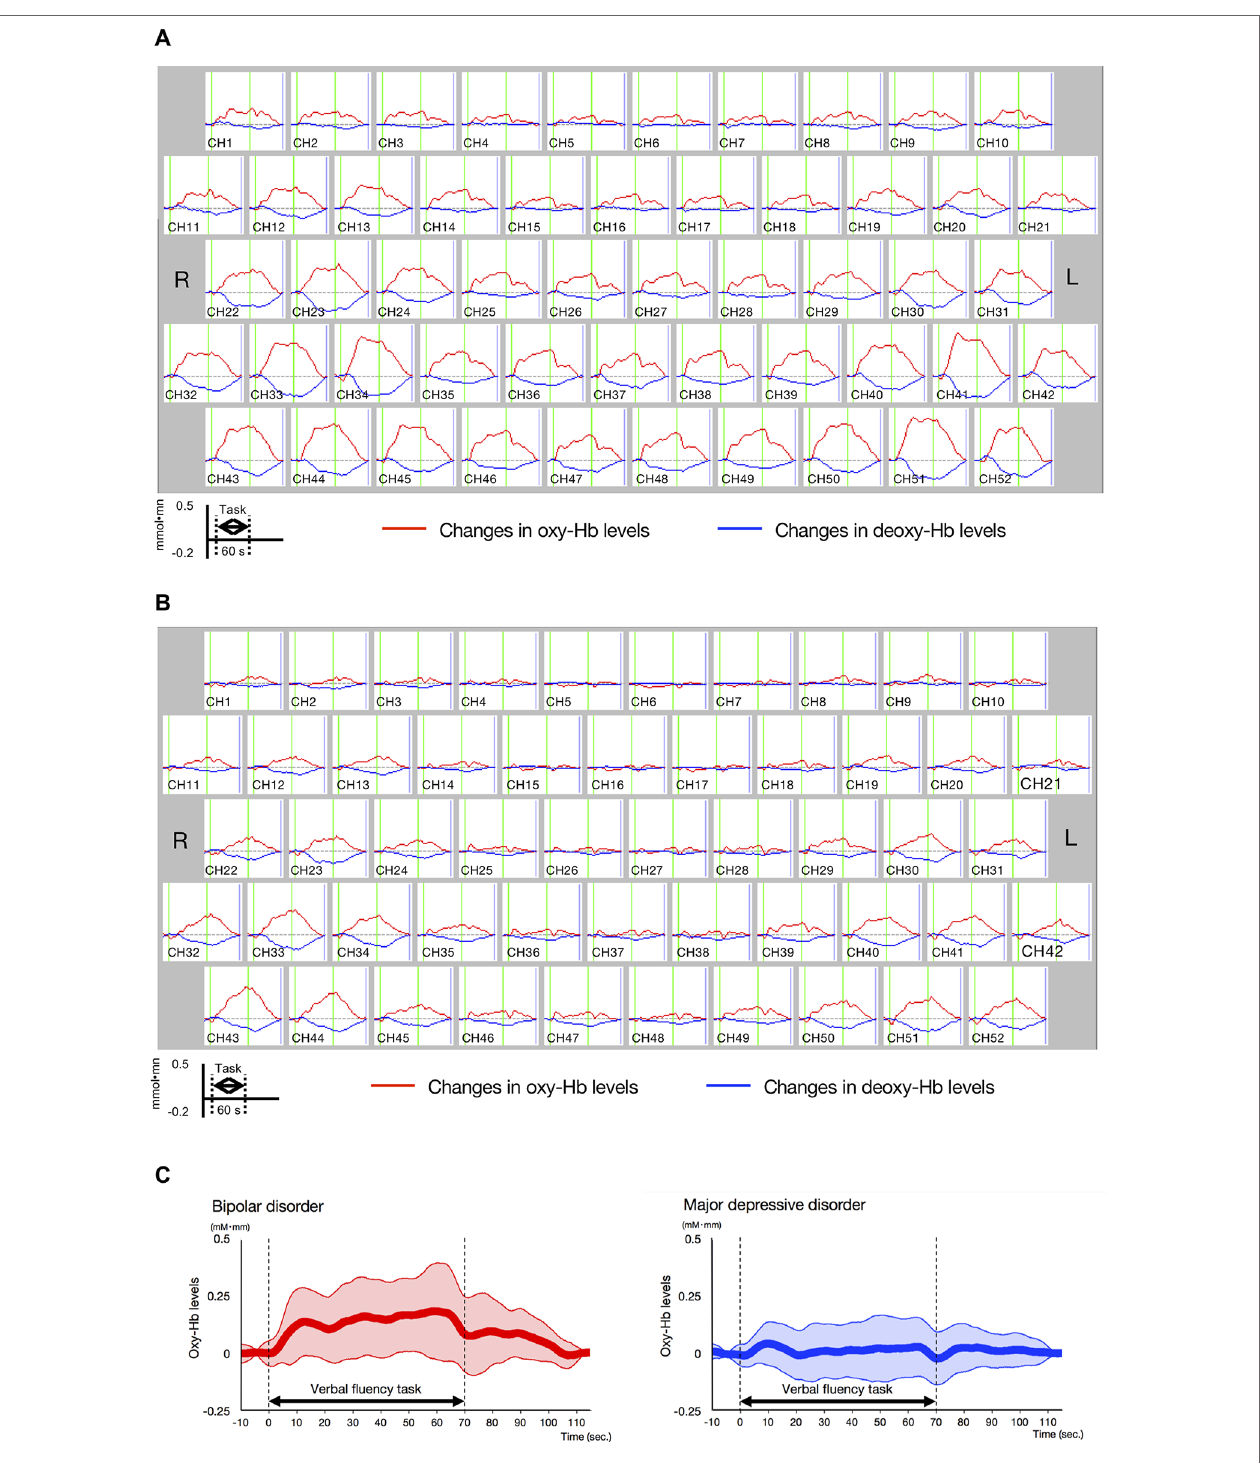
FIGURE 3 | Time-course changes in oxygenated hemoglobin and deoxygenated hemoglobin levels in bipolar disorder (BD) and major depressive disorder (MDD). (A) Time-course changes in BD. (B) Time-course changes in MDD. In the BD group, oxy-Hb levels gradually increased after the start of the task period and decreased gradually in the post-task period mainly in the prefrontal channels, while the oxy-Hb levels in the MDD group were lower than those in the BD group in frontotemporal channels across the task period. (C) Differential time-course changes in oxy-Hb levels between BD and MDD groups, for a channel 38, in which a significant difference in VFT-related oxy-Hb levels was observed between study groups. Standard deviations are shown as pale red (BD) and blue - dotted (MDD) areas. The oxy-Hb levels of the BD group gradually increased after the start of the task period, while these of the MDD group were smaller across the task